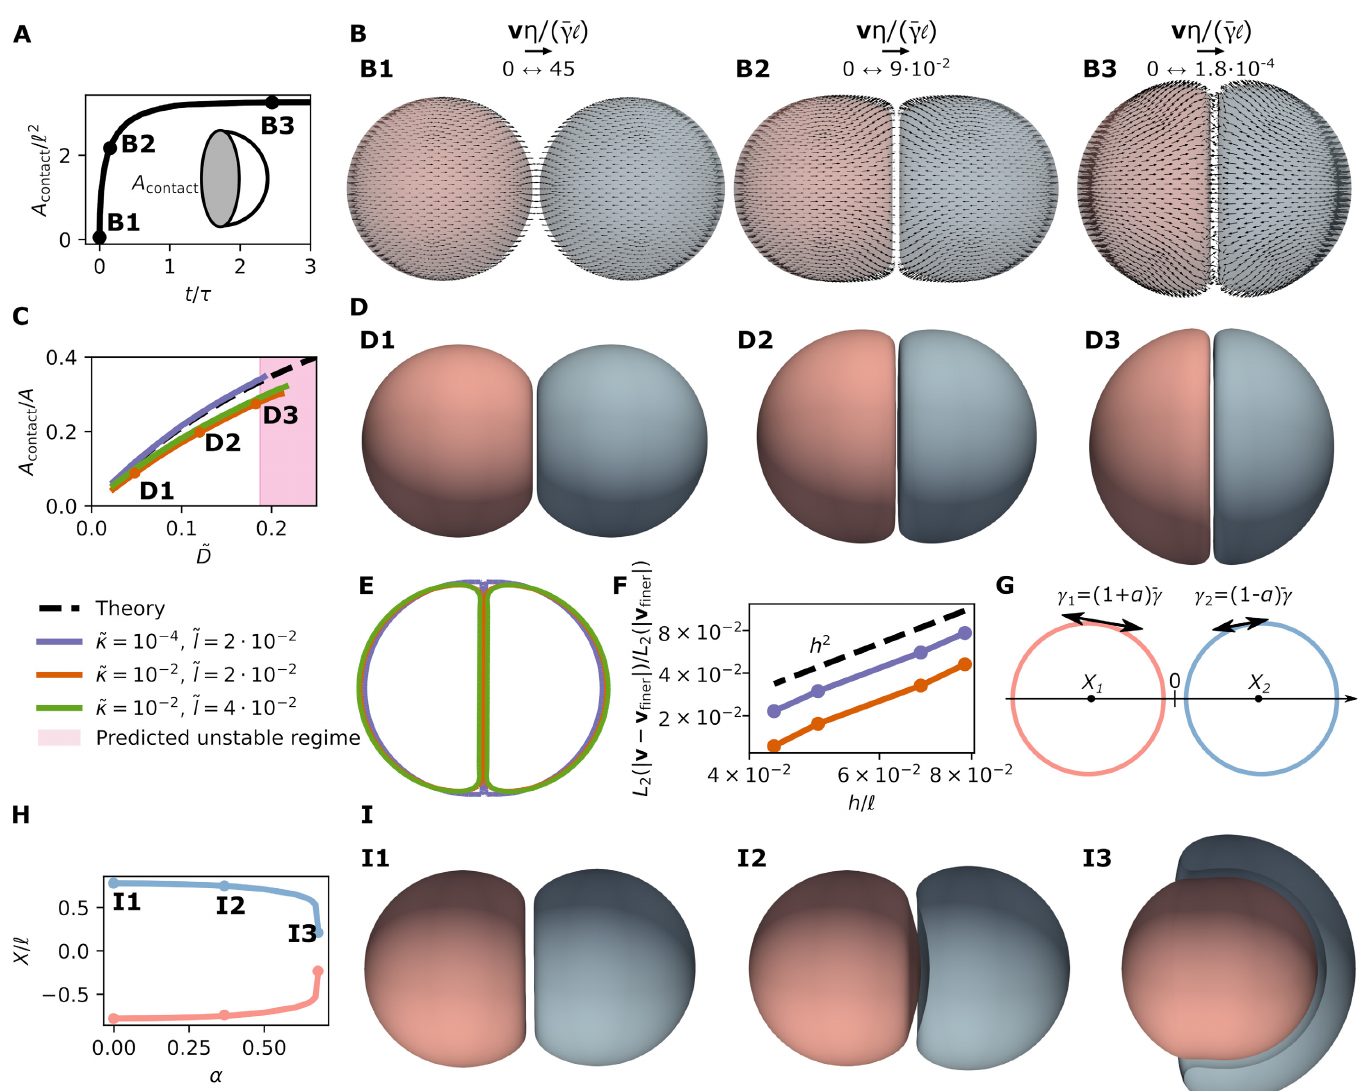
Fig 5. Dynamics and steady-state shape of a cell doublet. (A) Normalised area of contact as a function of time ( ~ k ¼ 10 (cid:0) 2 , ~ l ¼ 0 : 04 ). (B) Snapshots of deforming doublet at times indicated in (A), with the cell surface velocity field superimposed. (C) Coloured lines: ratio of contact surface area A with different values of ~ l and ~ k . Black dotted line: theoretical approximation valid in the limit of ~ k ! 0 ; ~ l ! 0 ; ~ r increasing adhesion strength; different parameters in (D1)-(D3) correspond to points labelled in C. (E) Comparison of a slice for the different simulations, with values of ~ l and ~ k indicated in C, and ~ D ¼ 0 : 14 . The value of ~ k affects the shape smoothness of the edge of the adhesion patch. (F) Convergence of the method evaluated by computing the L 2 -norm of the error in the initial velocity field for two different ~ D ( ~ D ¼ 0 : 05 (orange) and ~ D ¼ 0 : 15 (blue)), and different average mesh sizes h , and comparing the results with a simulation with h / ℓ � 2 � 10 − 2 (finer). (G) Schematic of adhering doublet, with different active tensions γ 1 and γ 2 for each cell. (H) Position of the cell centre of mass X 1 and X 2 , as a function of active tension asymmetry between the two adhering cells, α = ( γ 1 − γ 2 )/( γ 1 + γ 2 ), where γ 1 and γ 2 are the surface tensions of the two cells. Beyond α = 0.69, the cell with lowest tension completely engulfs the one with highest tension. (I) Snapshots of doublet equilibrium shape, clipped by a plane passing by the line joining the cell centres, for increasing difference of active surface tension; corresponding to points labelled in H. In H, I: ~ D ¼ 0 : 072 , ~ k ¼ 10 (cid:0) 2 , ~ l ¼ 0 : 04 .